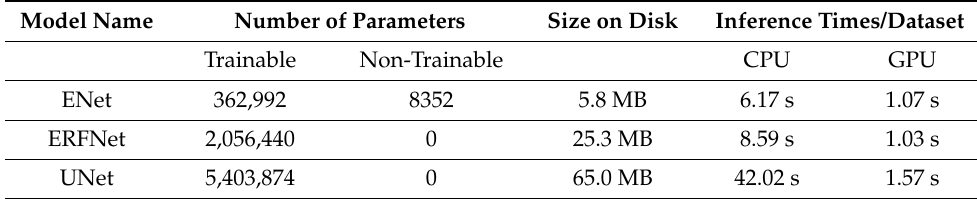
Table 5. Computational complexity of the three models.